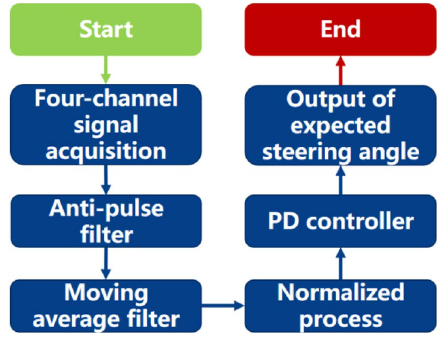
Figure 5 Flowchart of signal processing